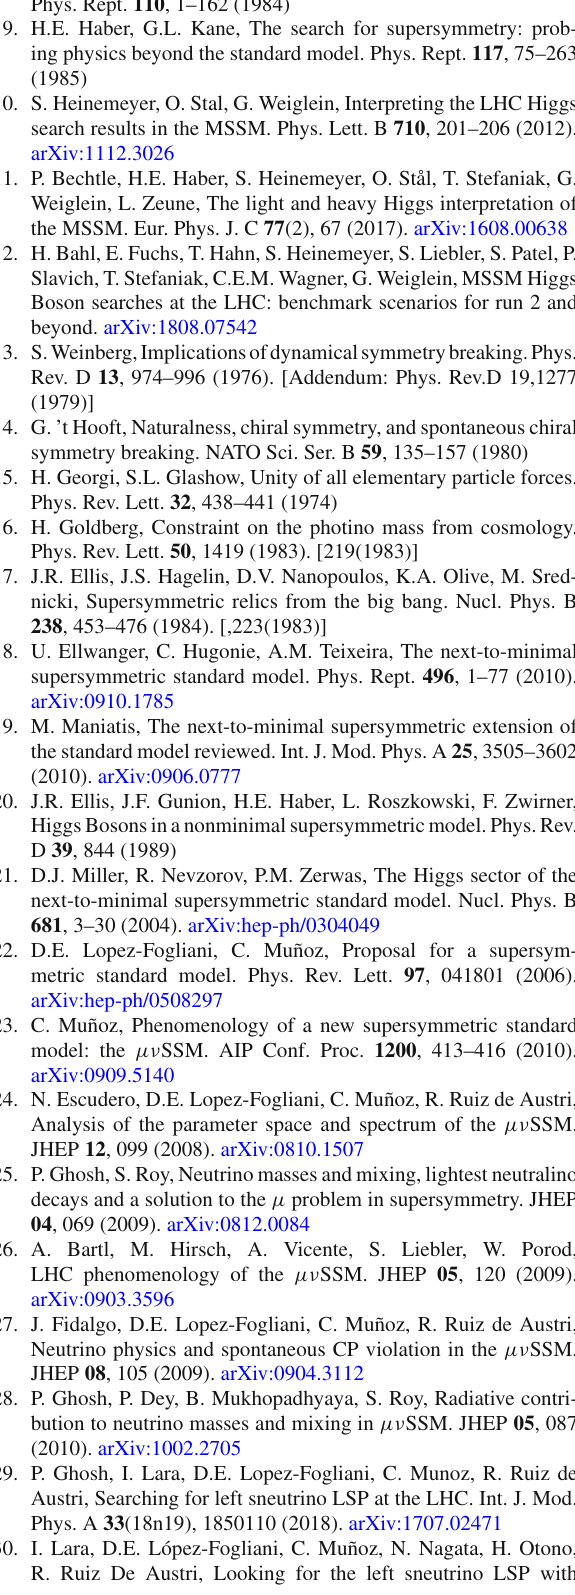
Table 7 Values for parameters of the standard model in GeV m OS